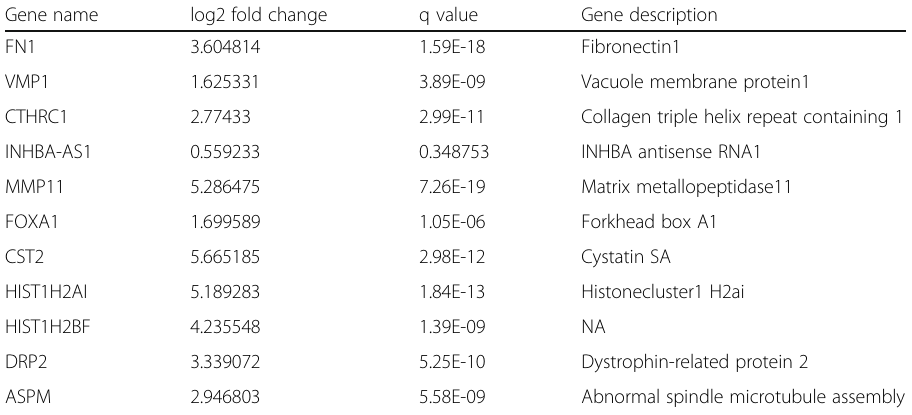
Table 4 Upregulated genes in breast cancer